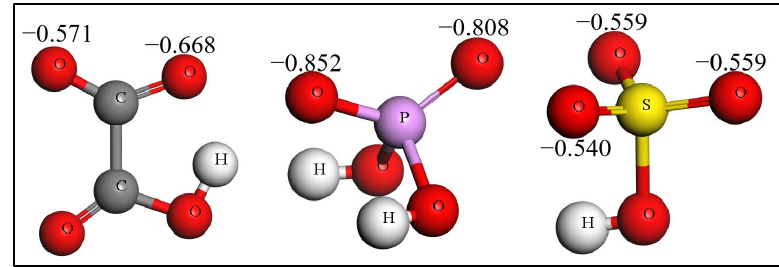
Figure 5. The charges of the O atoms in acid radicals.